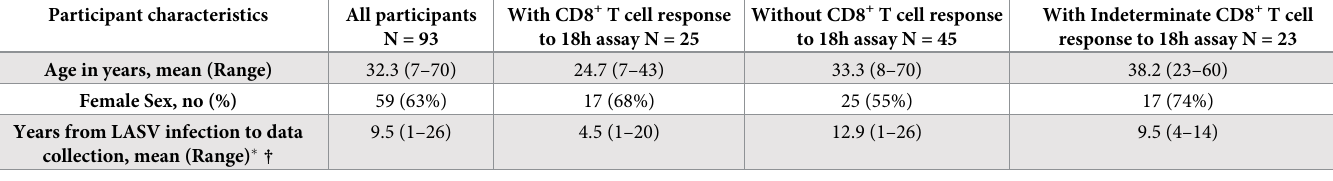
Table 1. Participant characteristics.